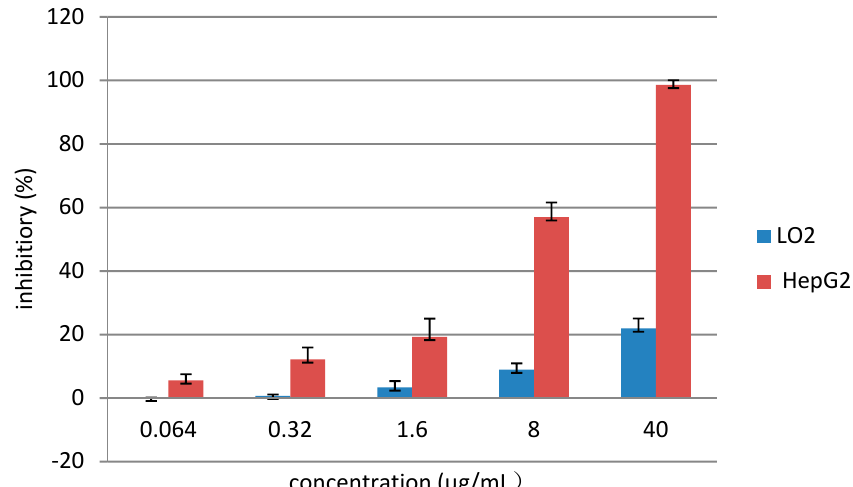
Figure 8. Inhibitory effects of compound 3j on the proliferation of HepG2 and LO2 cells. Data are means ± SD of the inhibition (%) from three independent experiments.